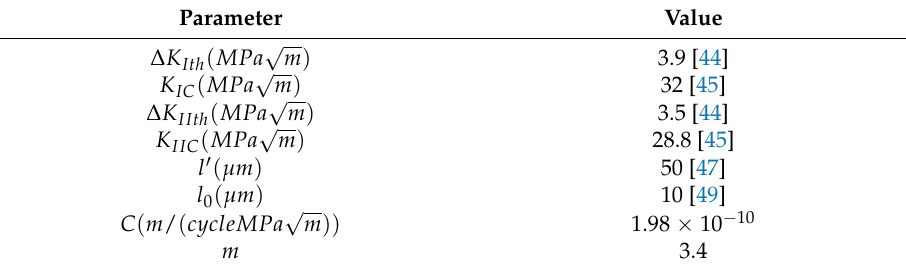
Table 2. Fatigue properties of aluminum alloy